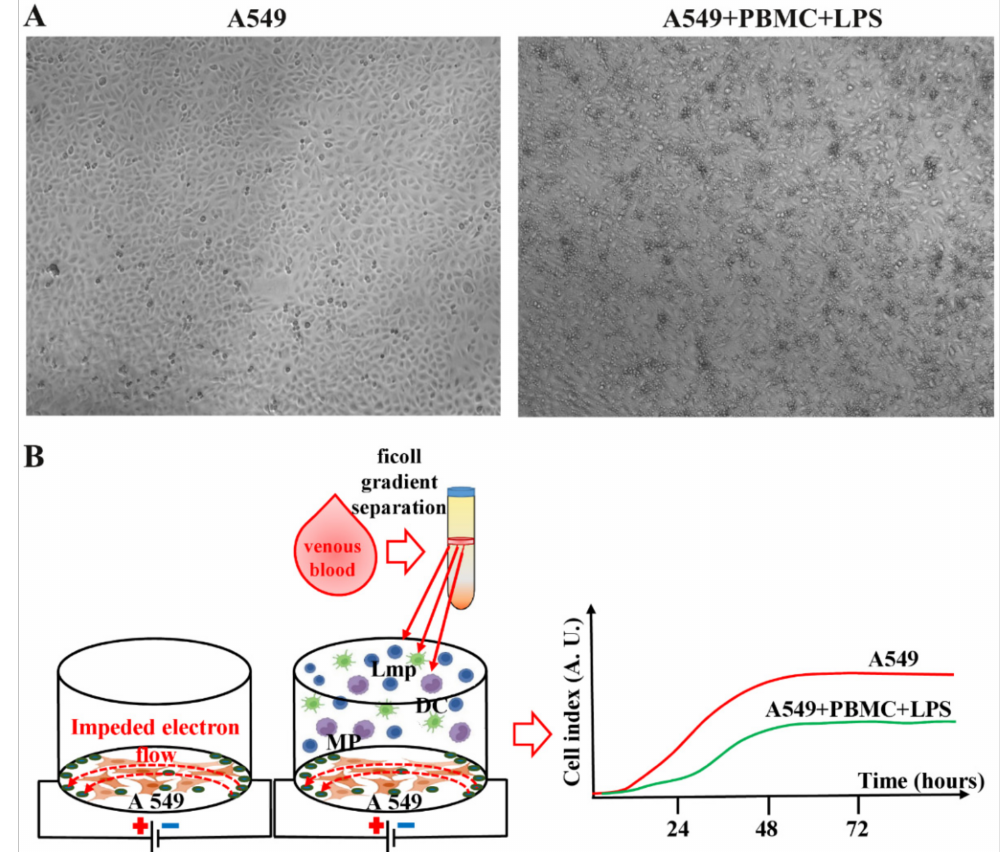
Figure 1. ( A ) Representative photomicrographs of untreated A549 cells and coculture A549 cells with PBMC activated by LPS after 24 h. Images acquired with 4x magnification through CELENA ® S Digital Imaging System (Logos Biosystems). ( B ) Experimental design. DC—dendritic cells; MP—macrophages;